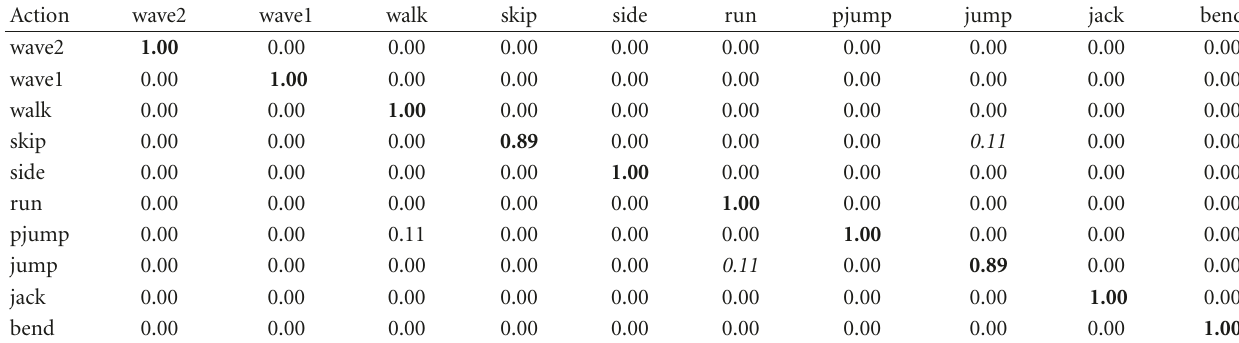
Table 3: Confusion matrix obtained on Weizmann